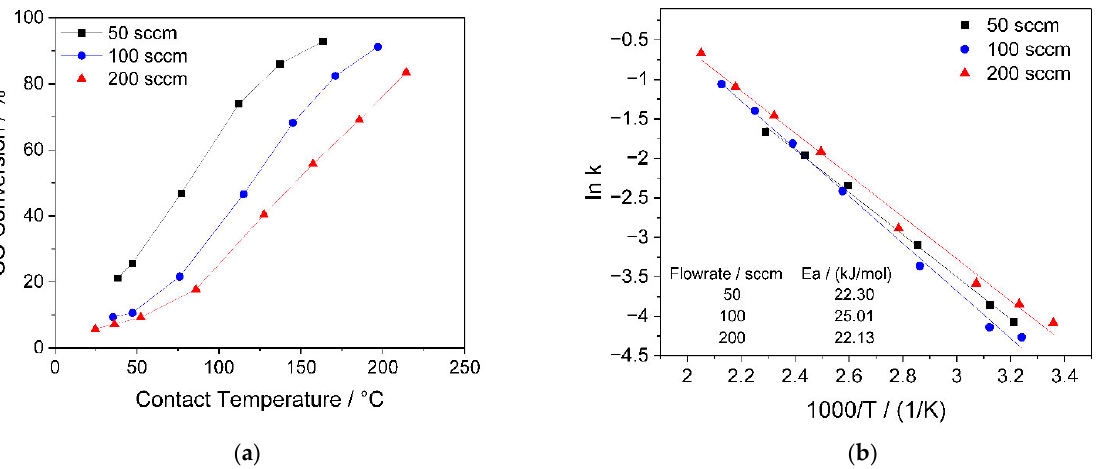
Figure 8. ( a ) Temperature ‐ dependent catalytic CO conversion over an LSC ‐ 82 catalyst as a func ‐ tion of different total flowrate and ( b ) Arrhenius ‐ plot of the data. of different total flowrate and ( b ) Arrhenius-plot of the